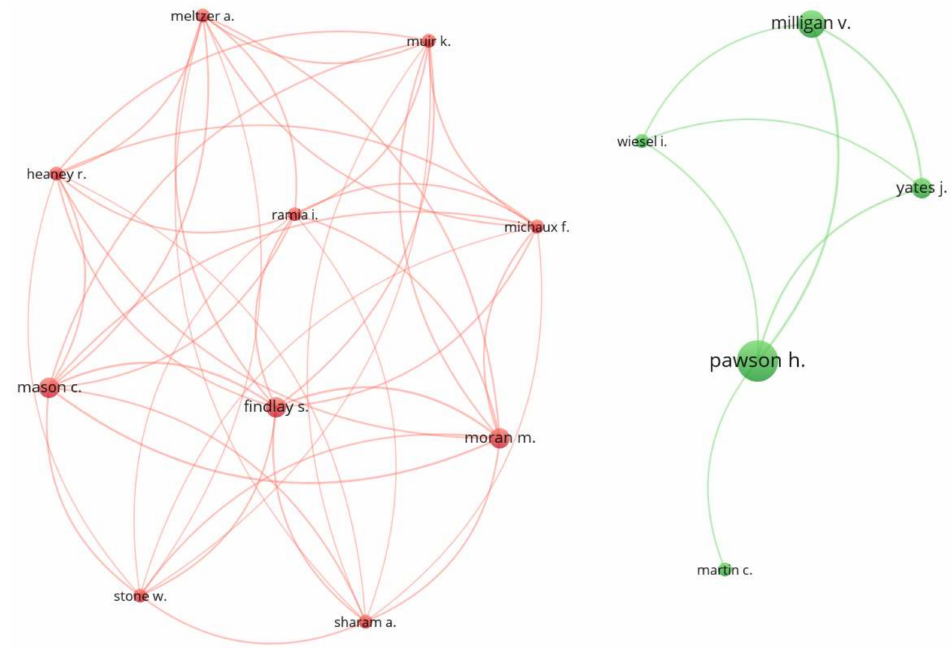
Figure 2. Authors’